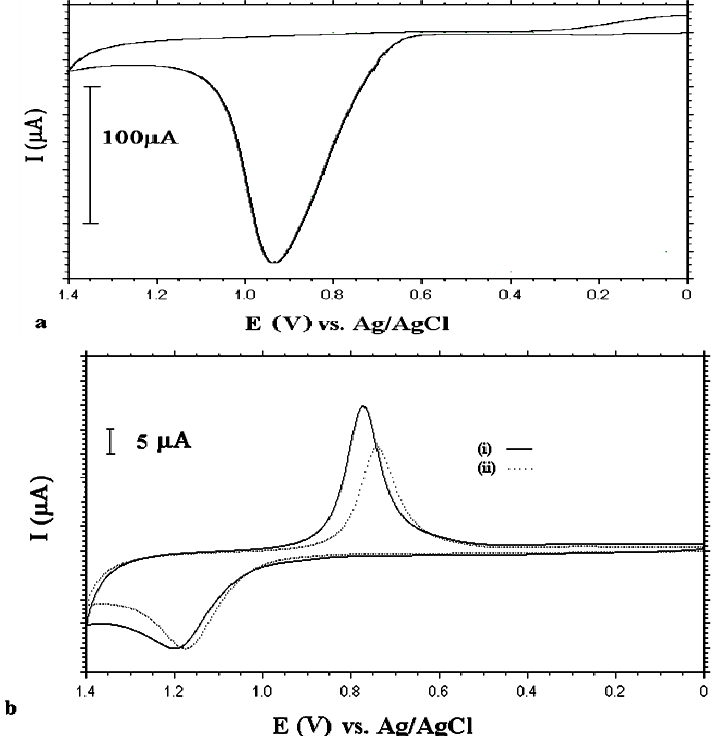
CV measurement : at 50 mV/s scan rate between 0.0 V and +1.4